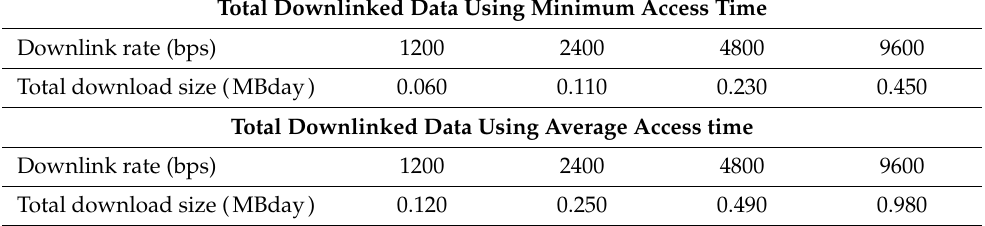
Table 5. Light-1 data